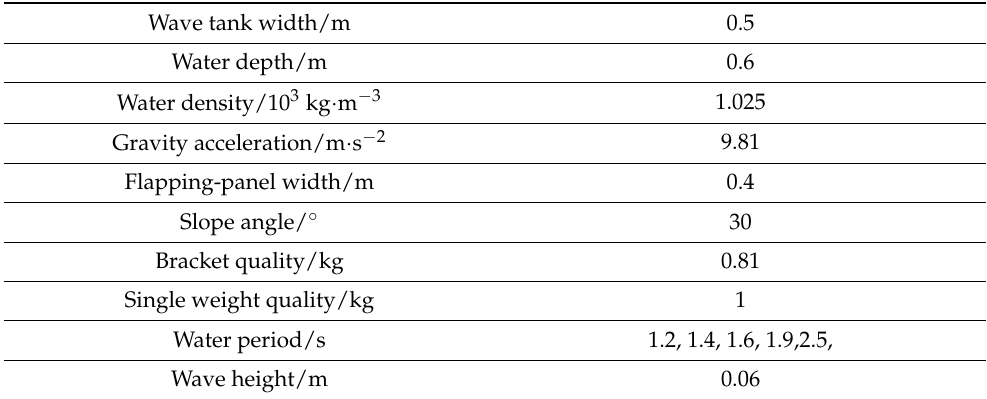
Table 3. Water tank test parameter